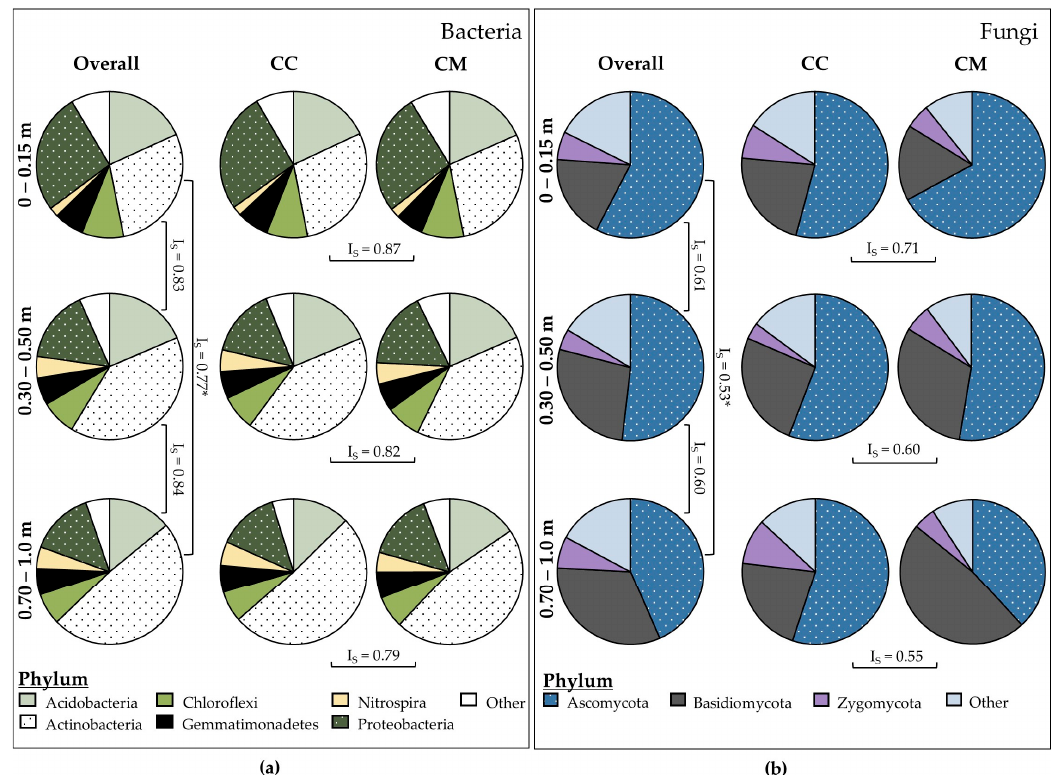
Figure 3. Similarities between microbial diversity profiles as determined by Sørensen’s Index of Similarity (I S ), with an asterisk (*) indicating a significant difference of p < 0.001 when α = 0.05. ( a ) Bacterial community profiles down the soil profile (overall) and as influenced by continuous cotton (CC) and cotton–maize (CM). ( b ) Fungal community profiles down the soil profile (overall) and as influenced by continuous cotton (CC) and cotton–maize (CM).